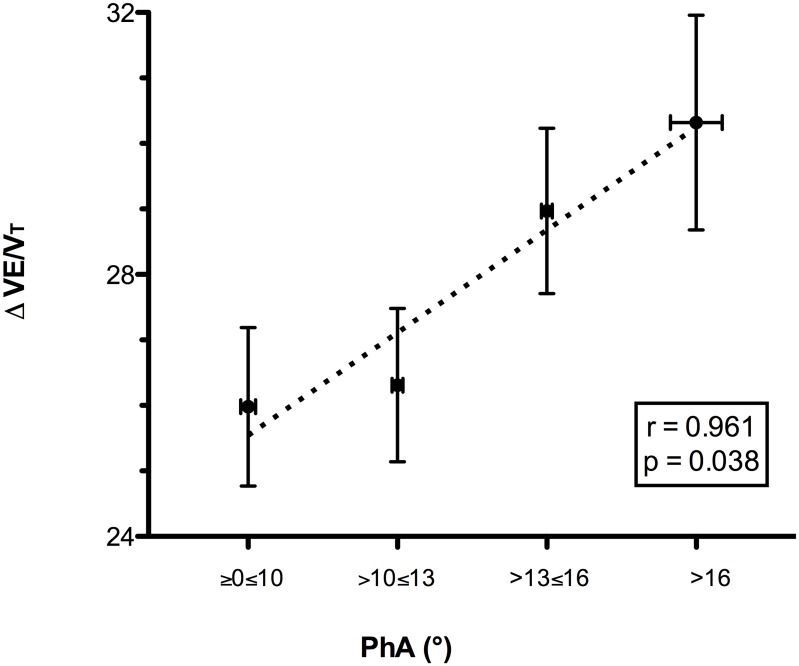
Relationship between the delta VE/VT ratio and thoraco-abdominal coordination (PhA) during the run.The PhA values were grouped into four classes, each associated with the delta VE/VT (difference between the VE/VT ratio during the run and at rest). Reductions in thoraco-abdominal coordination, indicated by an increase in PhA, were significantly related to increases in the VE/Vt ratio, which represents a less efficient ventilatory pattern. Abbreviations: PhA, phase angle; VE/VT, ratio between ventilation and tidal volume.